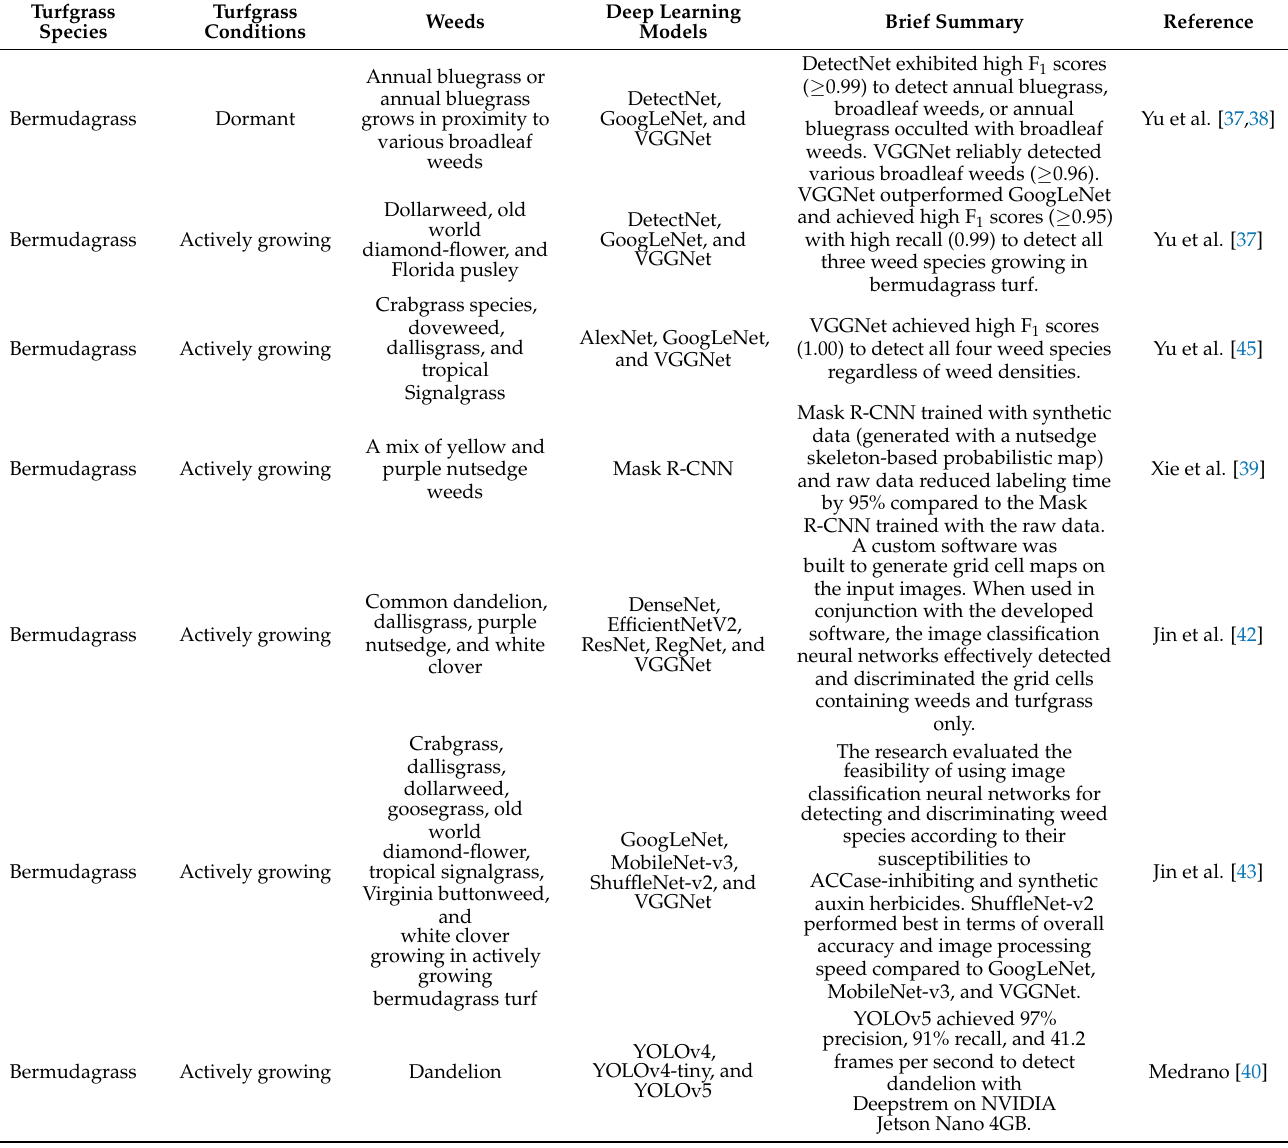
Table 1. A summary of published reports on the use of DCNNs for detecting weeds growing in